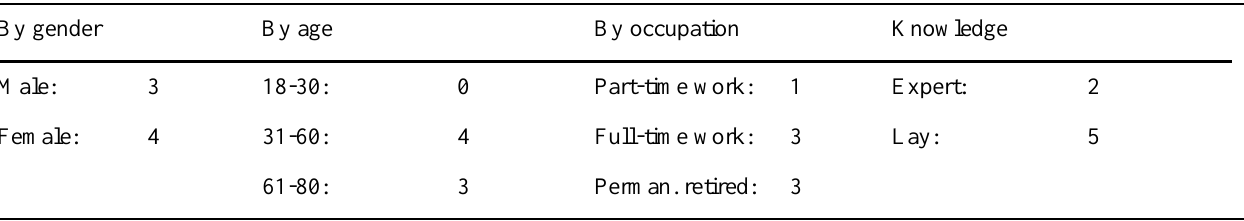
Table 1 . Summary of project participants sample